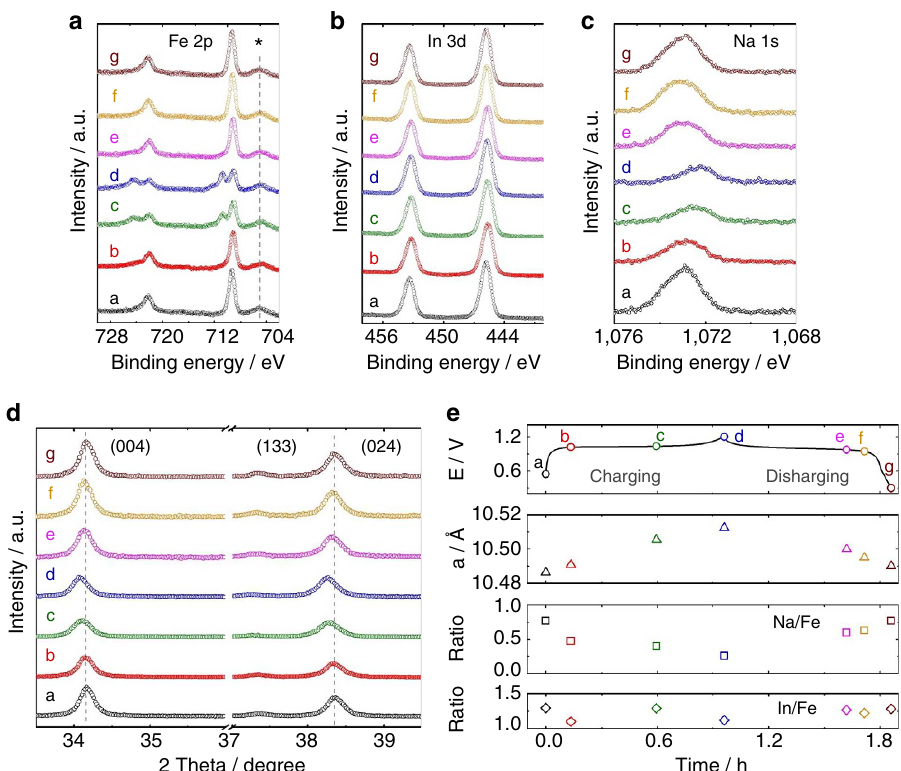
Figure 5 | Sodium-ion intercalation mechanism in InHCF. ( a – c ) Ex situ XPS spectra recorded from Fe 2 p , In 3 d and Na 1 s core level of InHCF/Gr upon electrochemical cycling (a–g states as shown in e are selected). A binding energy of 688.2eV for the F 1 s (from polyvinylidene fluoride (PVDF)) was used as reference. The peaks labelled by * symbol (705.0 ± 0.1eV) are related to In 3 p 1/2 . ( d ) Ex situ X-ray diffraction patterns of InHCF/Gr with cycling. ( e ) Changes of lattice parameter ( a ), surface atomic ratio (Na/Fe and In/Fe) in InHCF/Gr during electrochemical cycling. a, 0.55V, b, 1.02V, c, 1.035V, d, 1.2V, e, 0.975V, f, 0.945V and g, 0.3V seven states are selected for comparison.